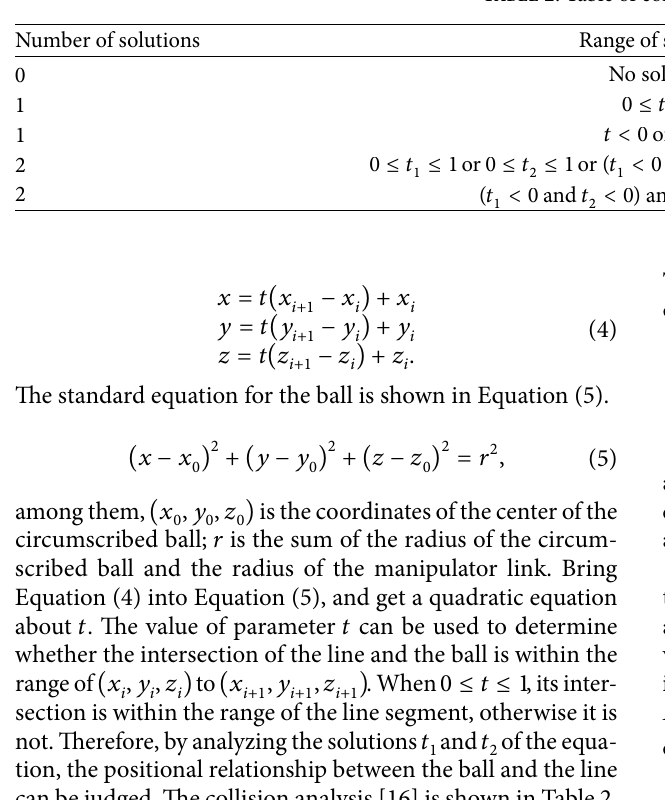
Table 2: Table of collision